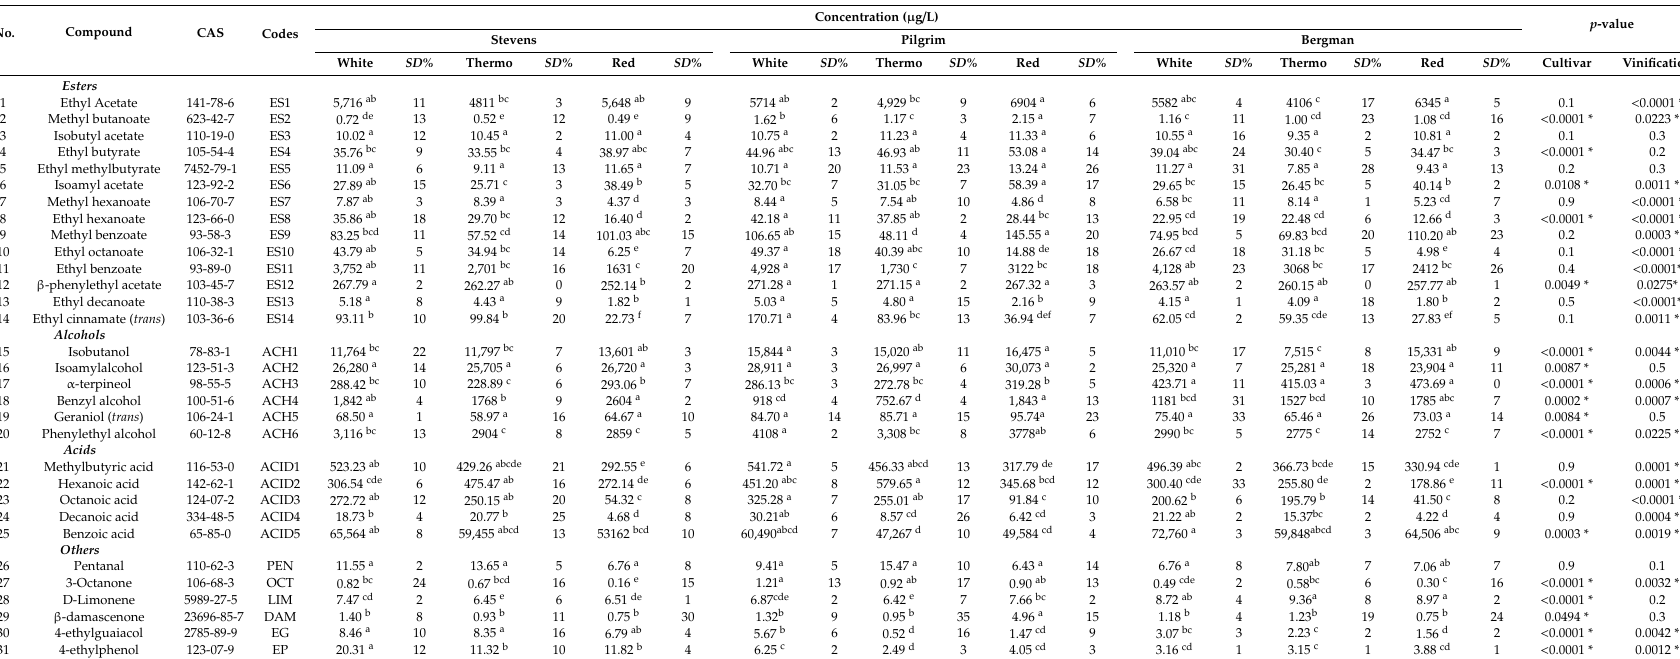
Table 3. Concentration of volatile compounds detected in cranberry wines by GC-MS (gas chromatography combined with mass